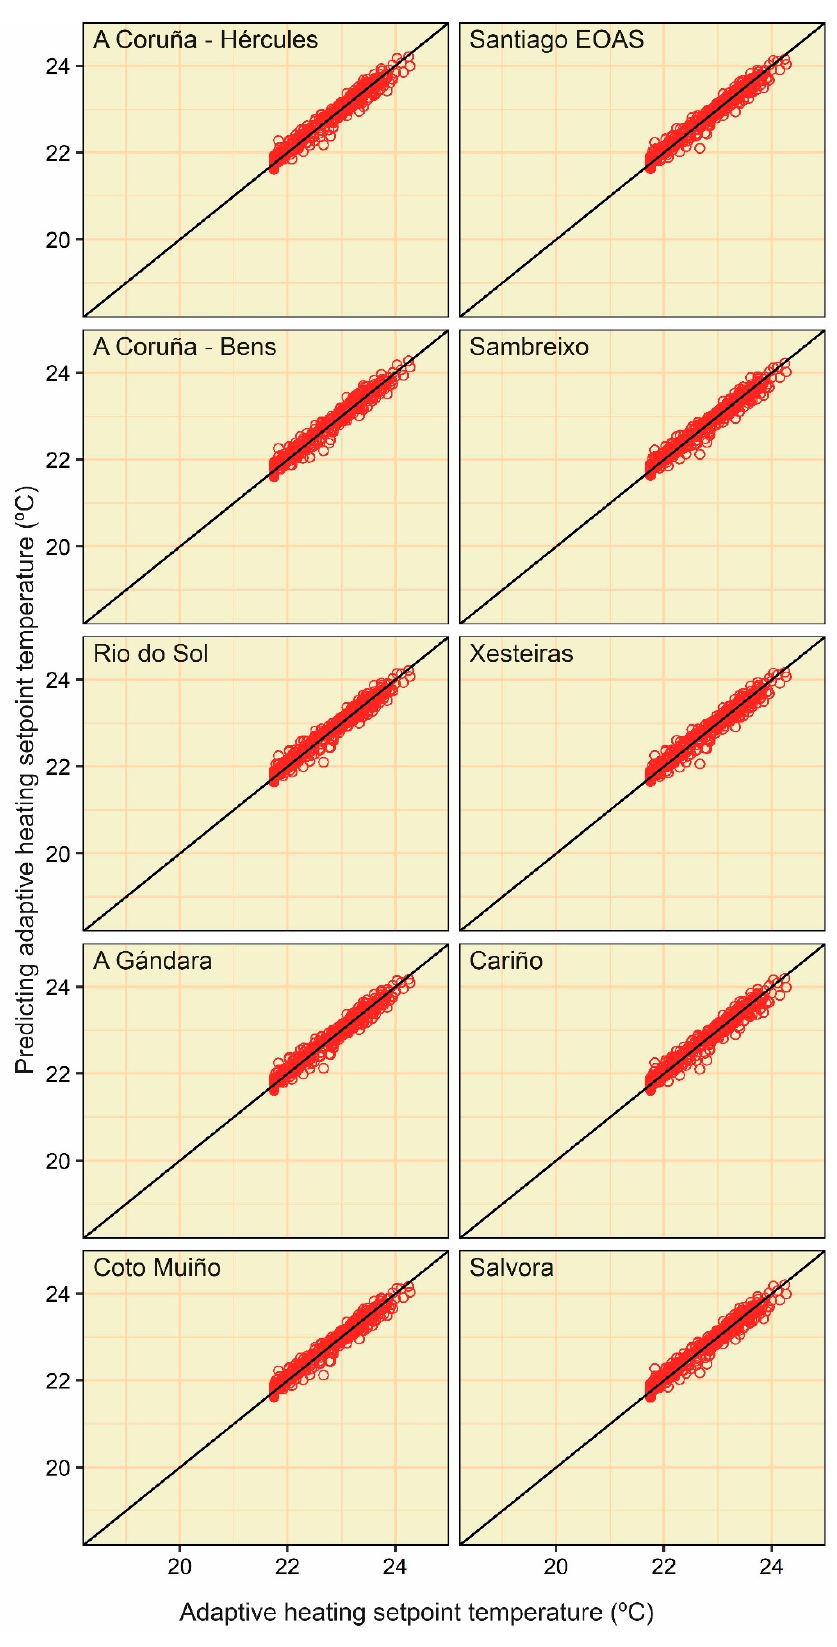
Figure A13. Point clouds between the actual and predicting adaptive heating setpoint temperature values (category I) of the MLR (approach 1).